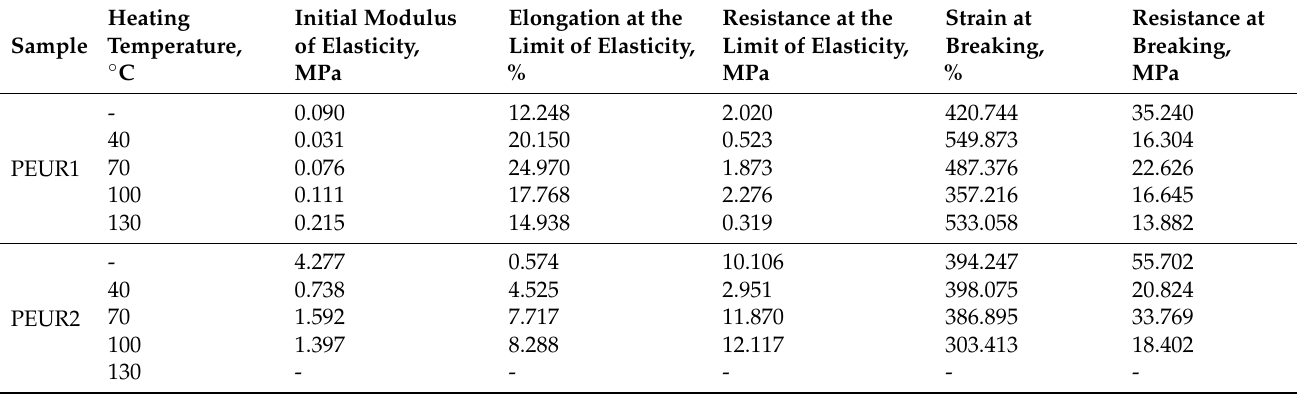
Table 5. Variation of physico-mechanical properties with temperature and aging